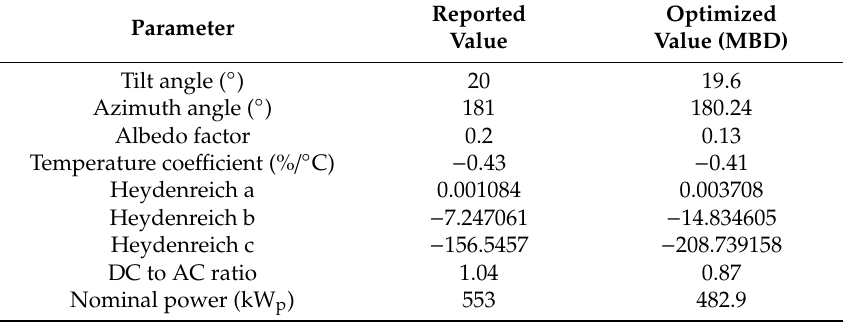
Table 4. Basic parameters reported from the PV plant located in south-west Germany and mean bias deviation (MBD) of 10 days optimized with a training data set comprised of clear-sky moments from 90 days before.